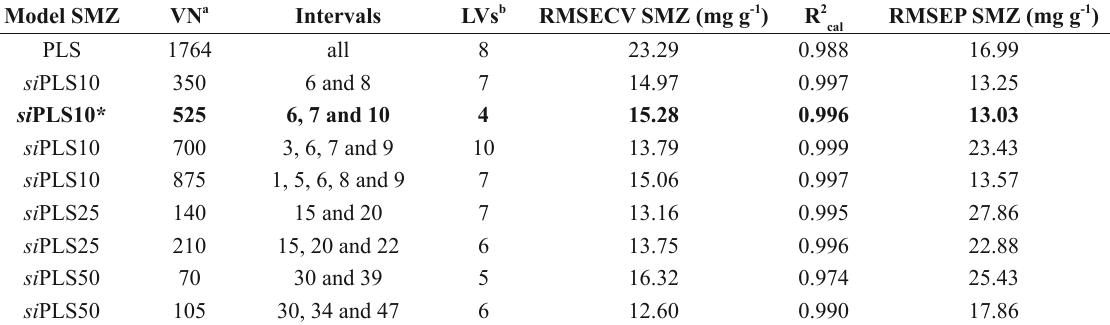
Statistical results to si PLS calibration models and full-spectrum PLS model for the